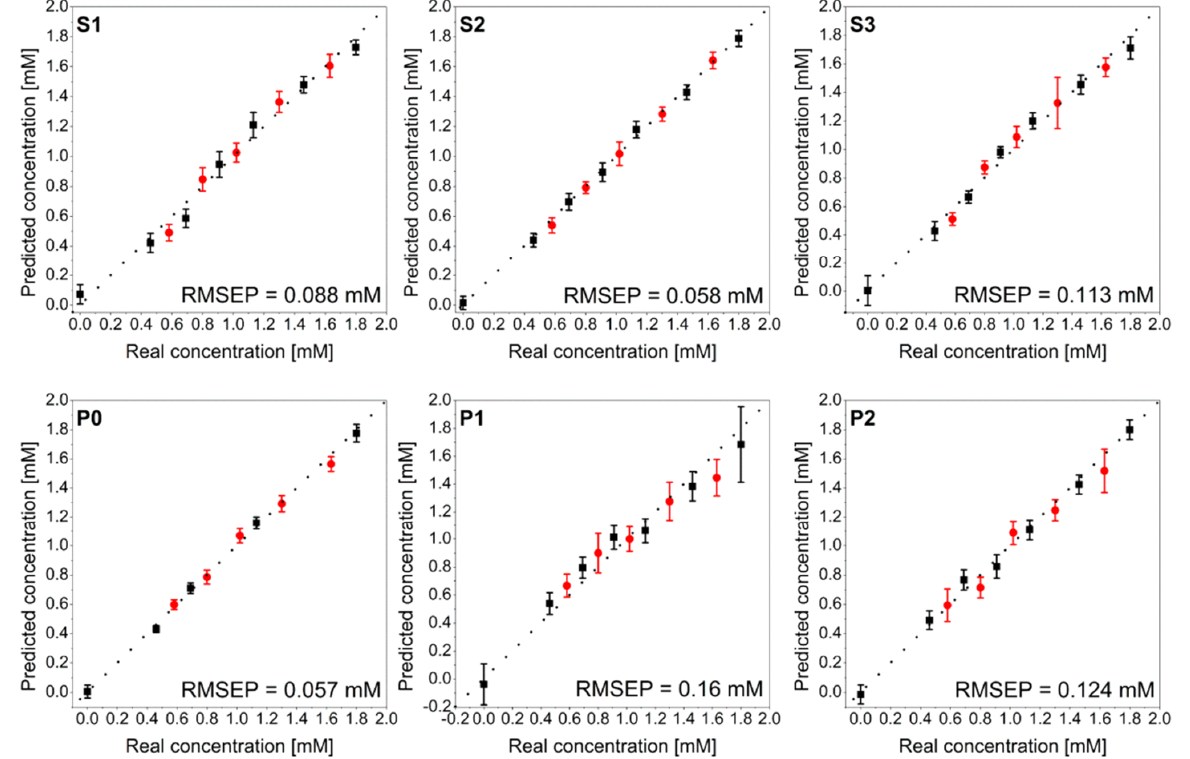
Figure 6. PLS prediction plots for spiked human urine samples (three individual, S1, S2 and S3, and three pooled urine samples, P0, P1 and P2) using seven concentrations for training (black scatter) and five (red scatter) for predicting. Reproduced with permission from [66]. Copyright 2016 American Chemical Society.